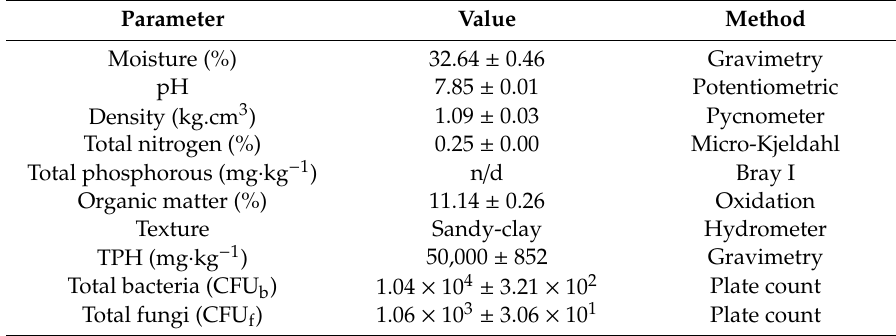
Table 2. The di ff erent analytical methods applied to determine the physicochemical parameters of the soil sampled, with each parameter carried out in